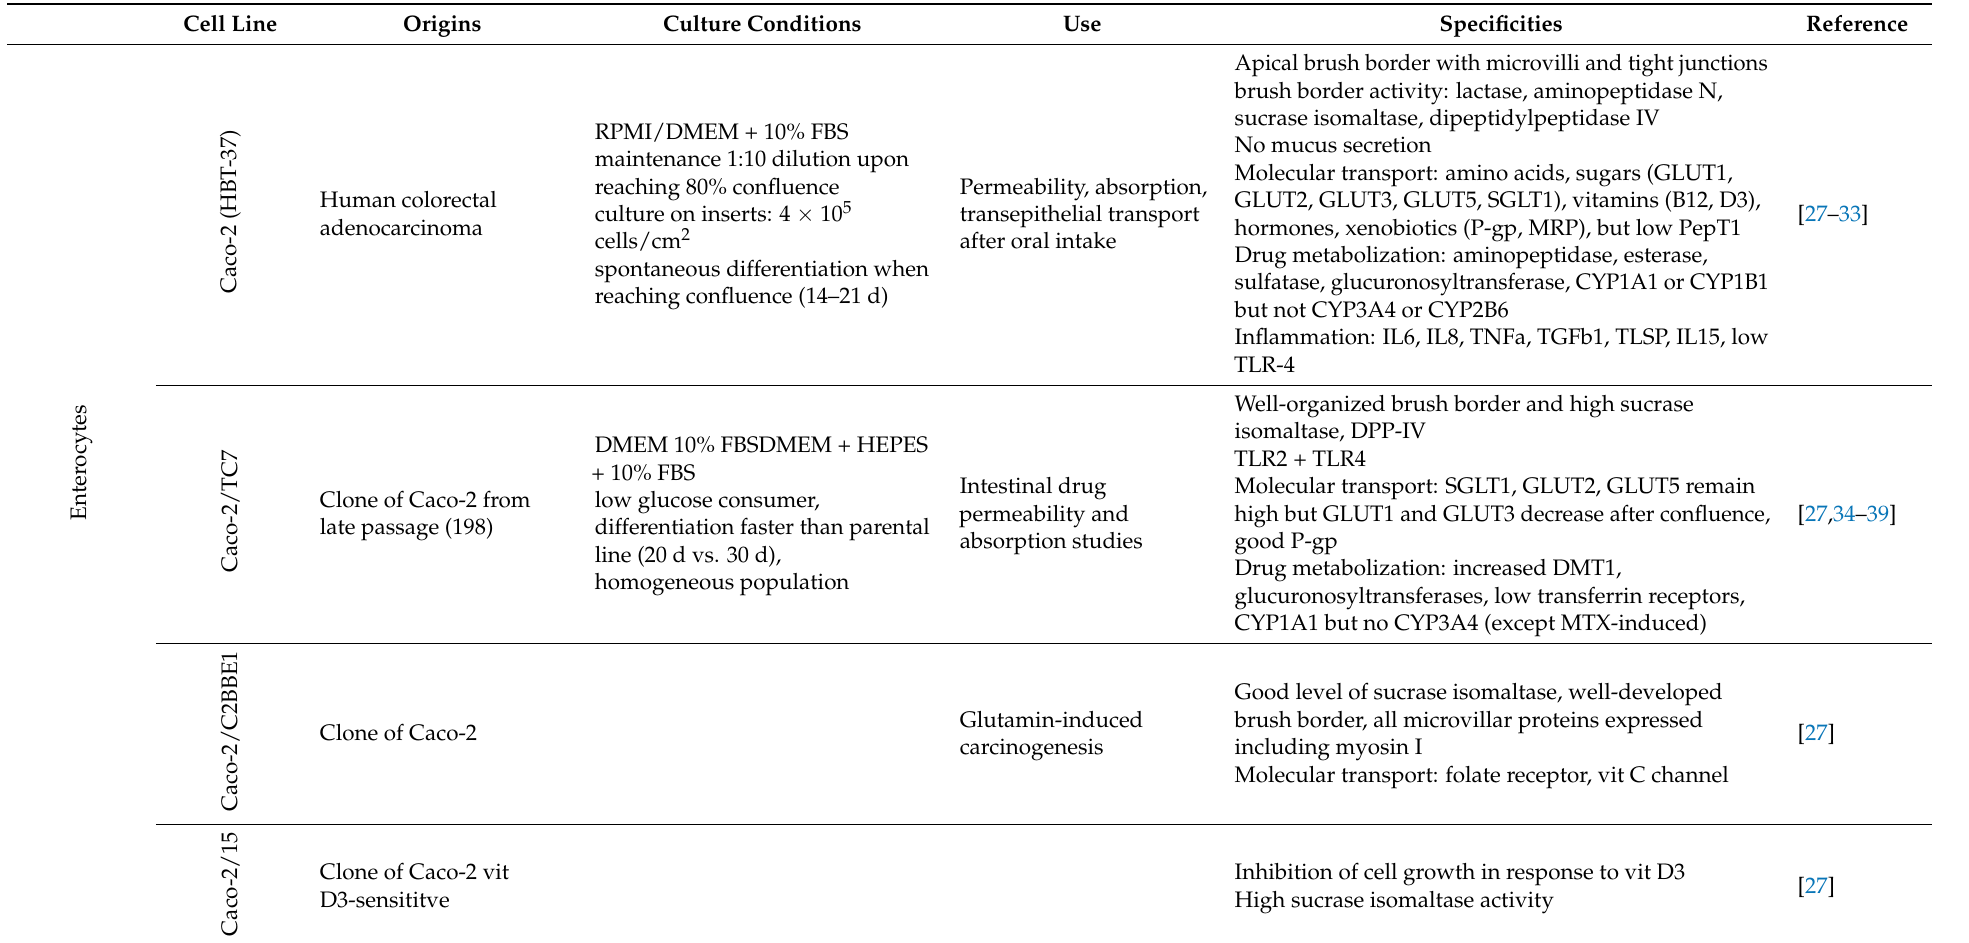
Table 1. Main epithelial cell